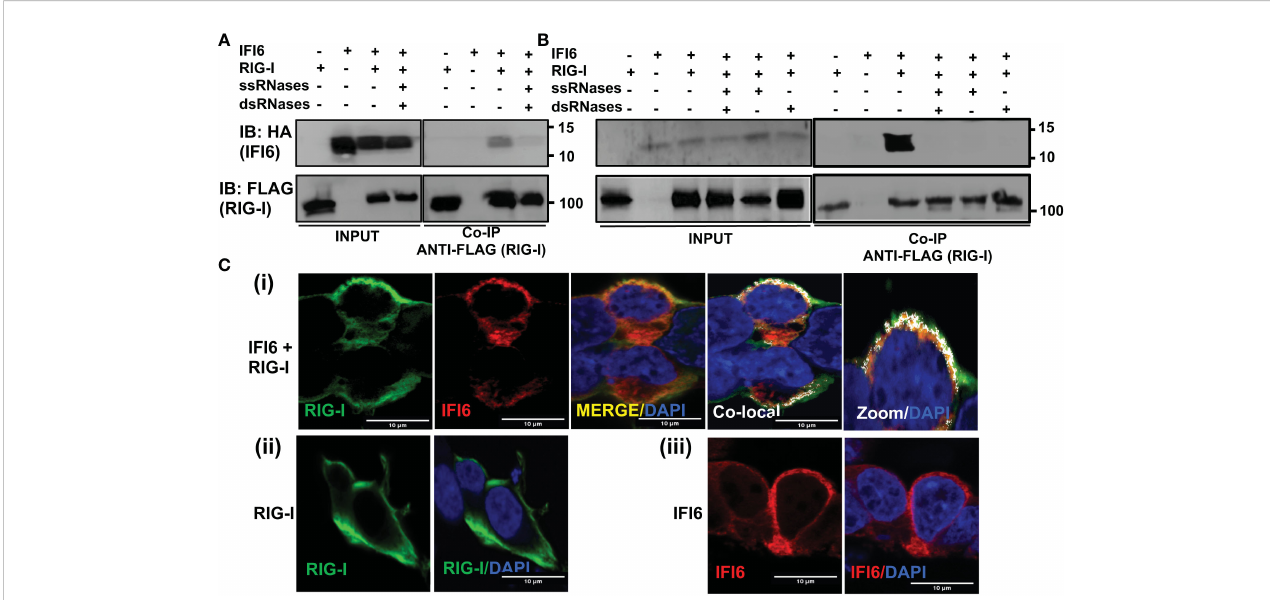
FIGURE 9 IFI6 interacts with RIG-I. (A, B) Human 293T cells were transiently co-transfected with the pCAGGS plasmids encoding IFI6-HA and RIG-I-FLAG, or with empty plasmids. Then, the cells were transfected with poly(I:C) during 24 h (A) or infected with SeV for 24 h (B) . (A, B) Cellular extracts were either treated with RNases digesting ssRNAs (ssRNases), RNases digesting dsRNAs (dsRNases), or non-treated with RNases. Coimmunoprecipitation (Co-IP) experiments using anti-FLAG to pull down RIG-I using af fi nity columns were performed. Western blotting using antibodies speci fi c for the HA tag (to detect IFI6, top panels) or the FLAG tag (to detect RIG-I protein, bottom panels) was performed to detect protein in the cellular lysates (Input) and after the Co-IP. IB, immunoblot. Molecular weight markers are indicated (in kilodaltons) on the right. Western blots after the IP were quanti fi ed by densitometry using ImageJ software, and the amounts of IFI6 were normalized to the amounts of RIG-I (numbers below the top blot). ND, not detected. Two independent experiments and Western blots were performed, with similar results. (C) Human A549 cells were transiently co-transfected with the pCAGGS plasmids encoding IFI6-HA and RIG-I-FLAG, or with empty plasmids. Then, the cells were transfected with poly(I:C) during 24 h. At 24 hpt, cells were fi xed with paraformaldehyde, and RIG-I-FLAG and IFI6-HA were labeled with antibodies speci fi c for the tags (in green and red, respectively), and nuclei were stained with DAPI (in blue). Pictures show cells co-transfected with plasmids expressing RIG-I and IFI6 together (i), and cells transfected with the plasmids expressing RIG-I (ii) and IFI6 (iii) separately. (i) Areas of co-localization of both proteins appear in yellow in the third picture and in white in the fourth picture. A zoom of the colocalization image (from fourth picture) is depicted in the fi fth picture. Scale bar, 10 m